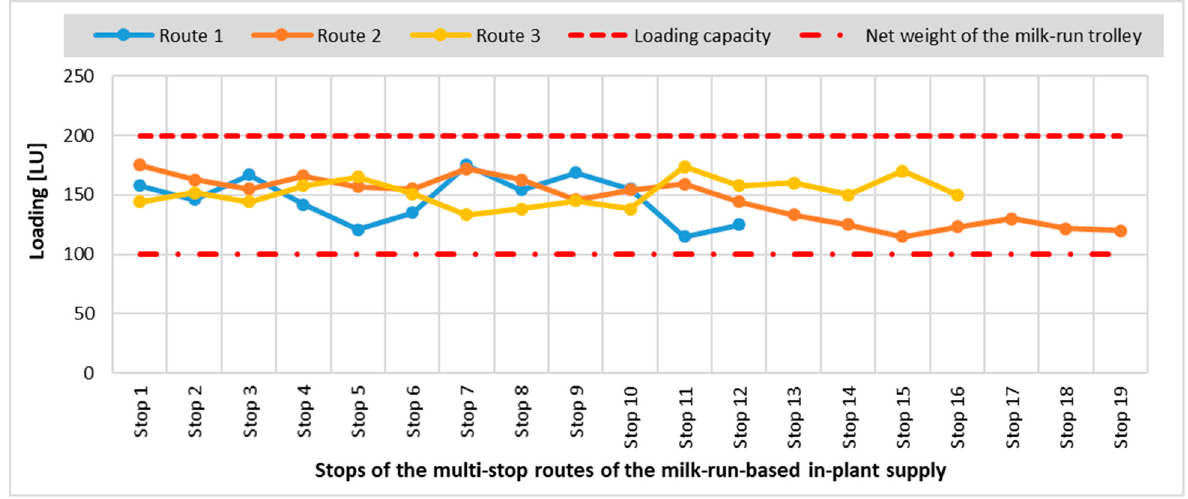
Figure 6. The optimized loading capacity of the three milk-run trolleys.